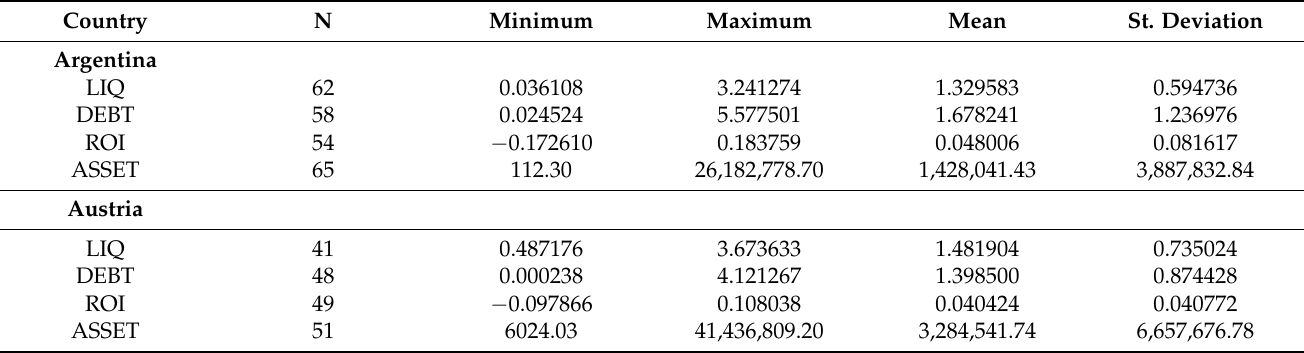
Table A1. Descriptive statistics for variables used to characterize the companies in the